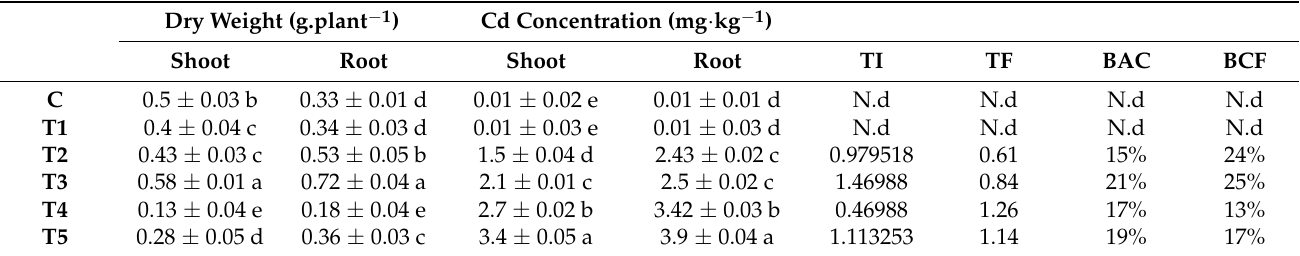
Table 4. Biomass, Cd concentration, tolerance index (TI), translocation factor (TF), biological ac- cumulation coefficient (BAC), and biological concentration factor (BCF) in A. rosea at different Cd